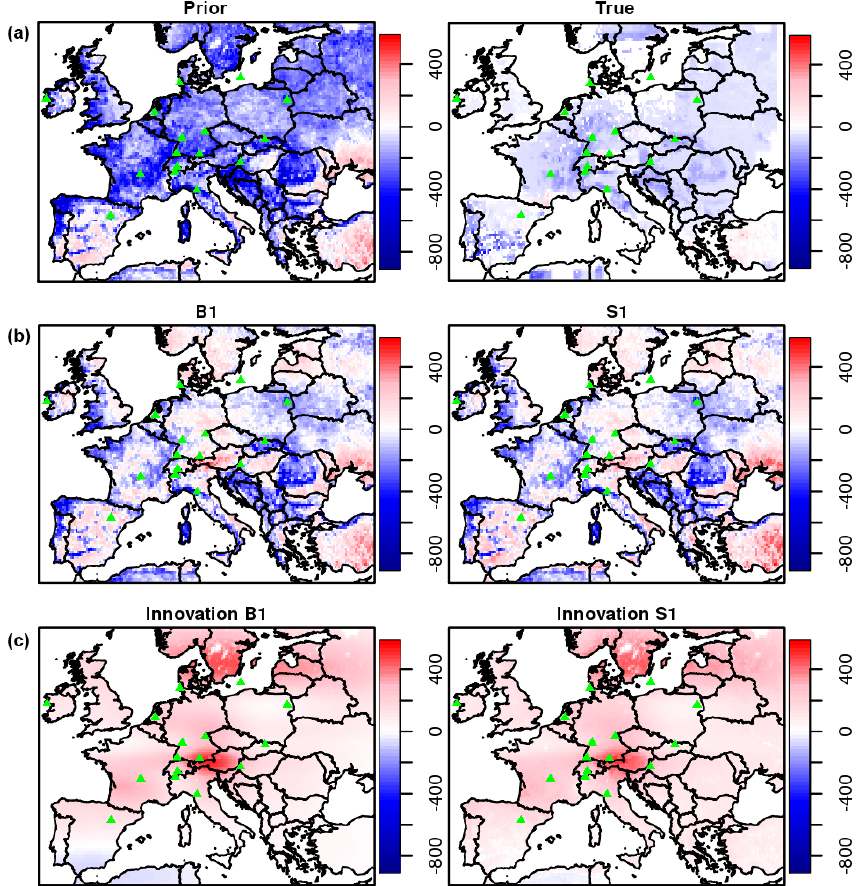
Figure 5. Annual spatial distribution for the prior, true and posterior biogenic flux estimates for the two synthetic inversions S1 and B1 (a, b) , and flux innovation defined as the difference of posterior minus prior (c) . Fluxes are given in units of gCm − 2 yr − 1 .